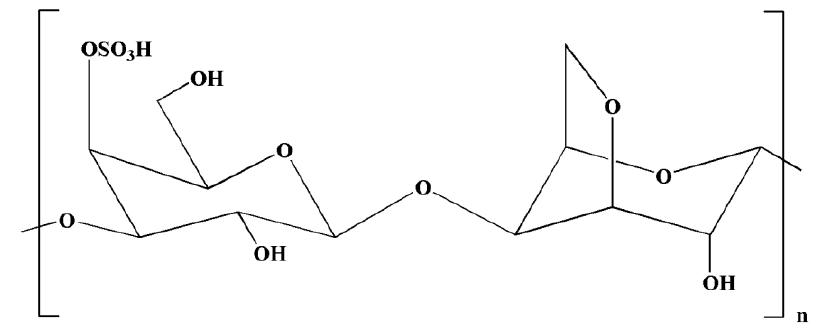
Figure 5. Chemical structure of kappa-carrageenan.